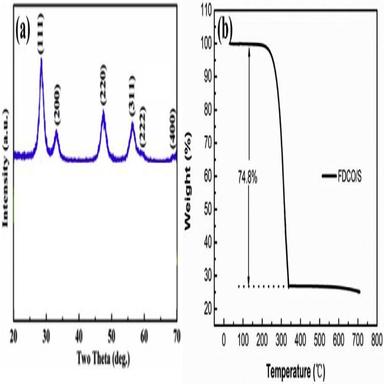
(a) XRD pattern of FDCO. (b) TG curve of the FDCO/S composites.